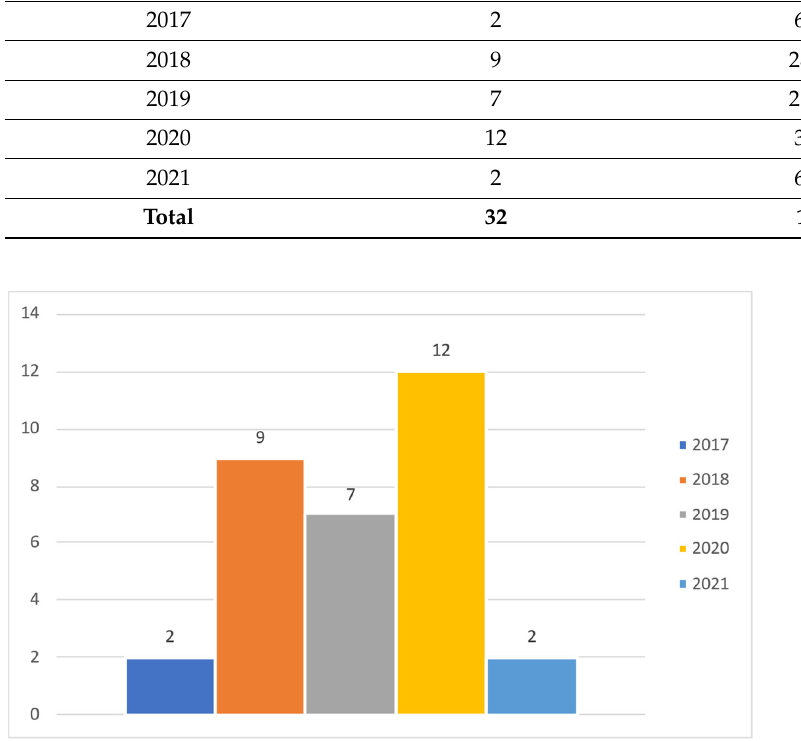
Figure 7. Distribution of Scientific Papers by Year.